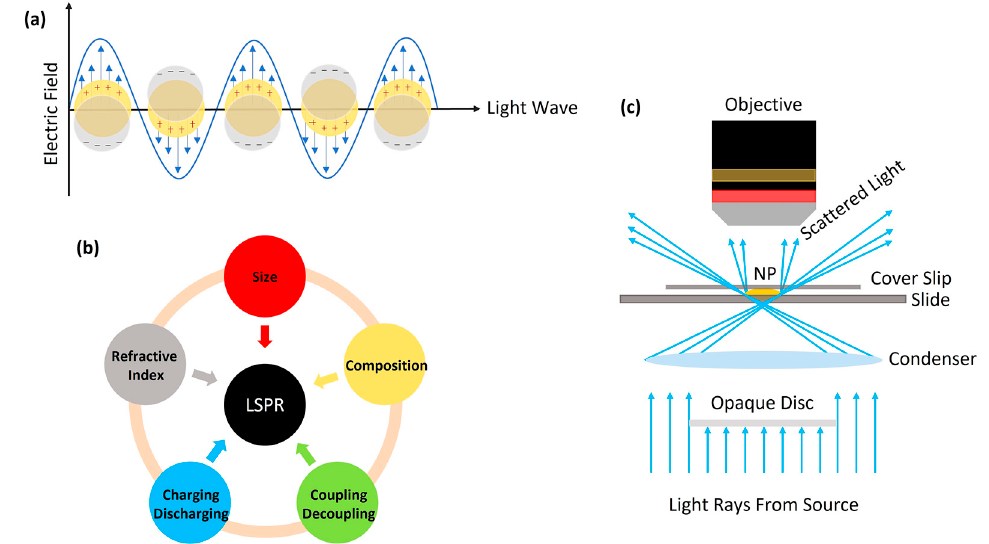
Figure 7. ( a ) Schematic illustration of the LSPR of a metallic and spherical nanoparticle. ( b ) The main influencing factors and adjustment strategies on LSPR of the plasmonic NPs. ( c ) Schematic diagram of one dark-field microscope.